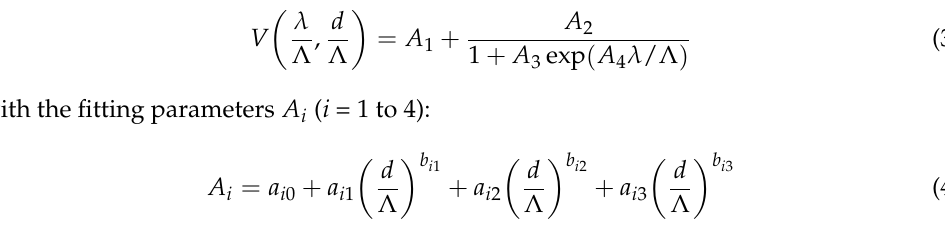
Table 1. Fitting coefficients in Equation (4).